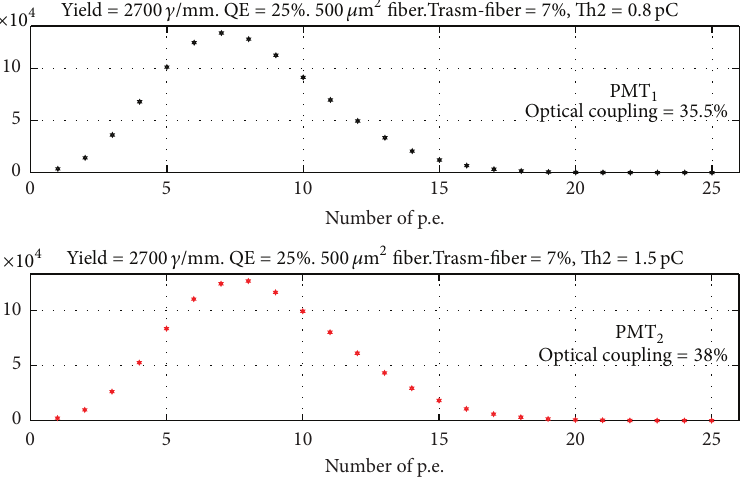
Figure 13: Spectra of the expected output from the two photomultipliers in a number of